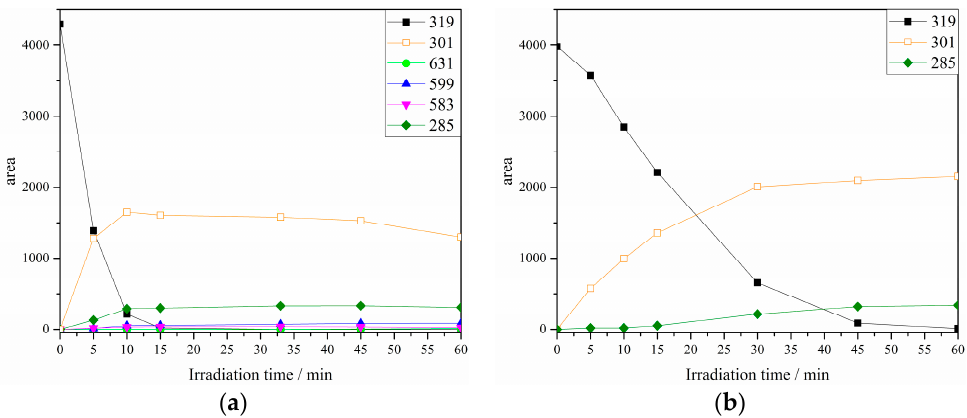
Figure 7. Conversion of chlorpromazine into its metabolites under anaerobic conditions: ( a ) photolysis upon UV(A) irradiation, ( b ) photocatalysis upon UV(A) irradiation with K-7000 as photocatalyst (1 g L − 1 ).